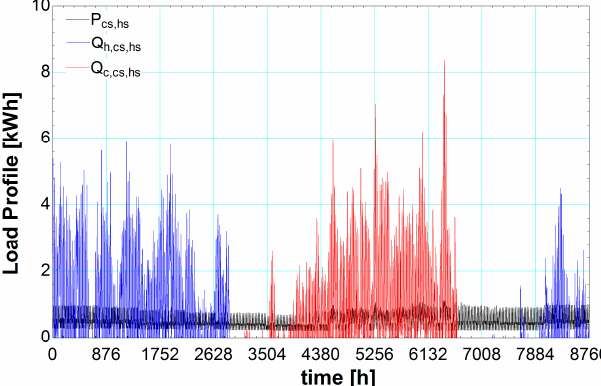
Figure 5. Annual load profile (power, heating, and cooling) for the average household considered